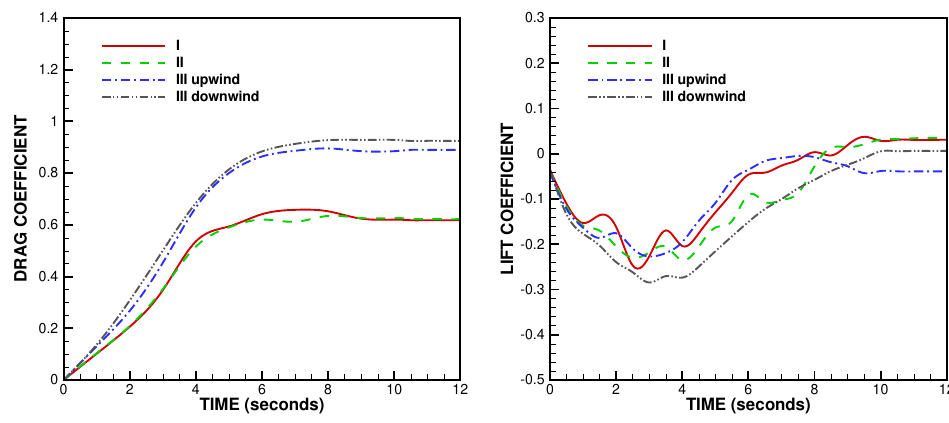
Figure 17. MLG: time history of drag and lift coefficients for the gear structure.